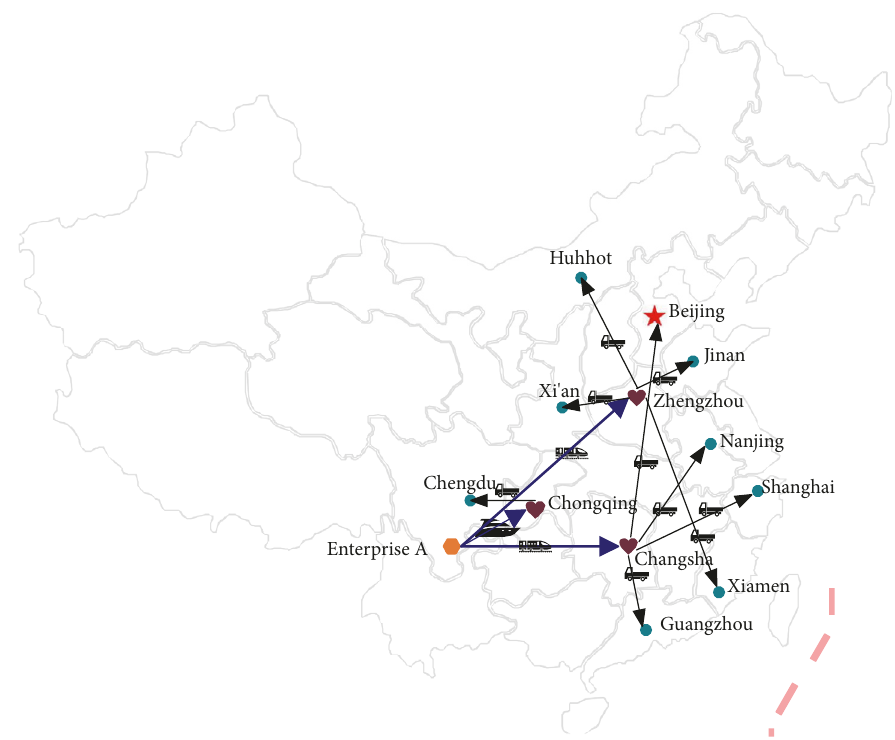
Figure 6: Optimal solution by minimizing the costs of Enterprise A, S1.